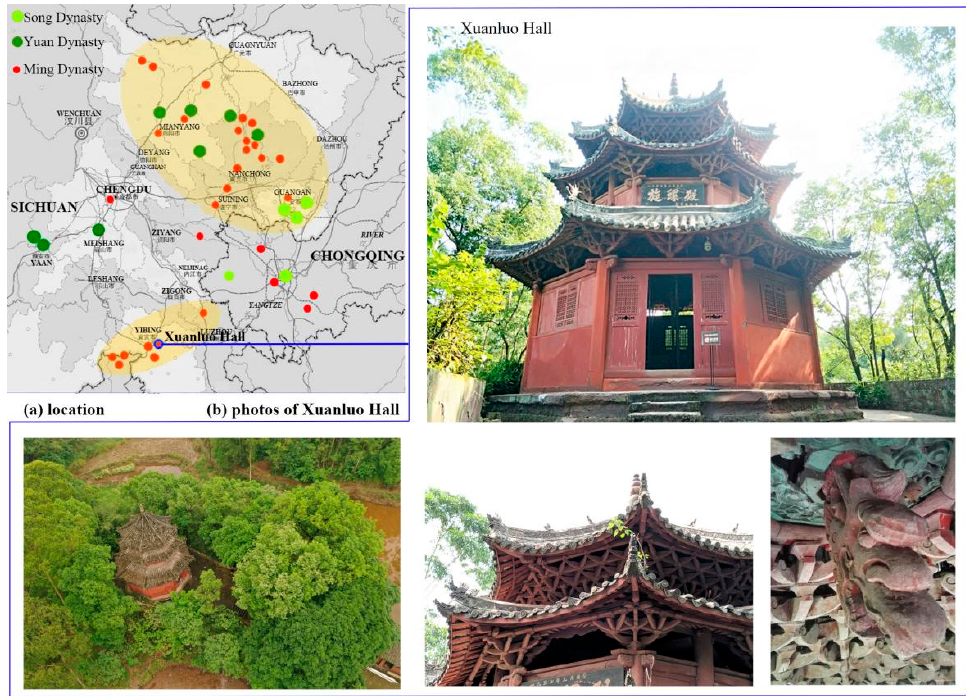
Figure 3. Study site: ( a ) Location; ( b ) The photos of Xuanluo Hall.